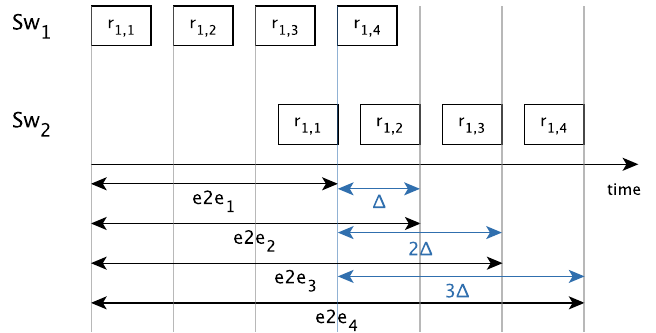
Figure 14. This figure shows the end-to-end delay of four replicas transmitted through a link between two bridges (Sw1 and Sw2). Specifically, the figure shows the transmission of four replicas with their respective maximum end-to-end delays marked with black arrows, i.e., e2e1 is the maximum end-to-end delay when transmitting a single replica, e2e2 is the maximum end-to-end delay when transmitting two replicas, etc. Moreover, the blue arrows show the variation between the end-to-end delays, a.k.a. jitter.